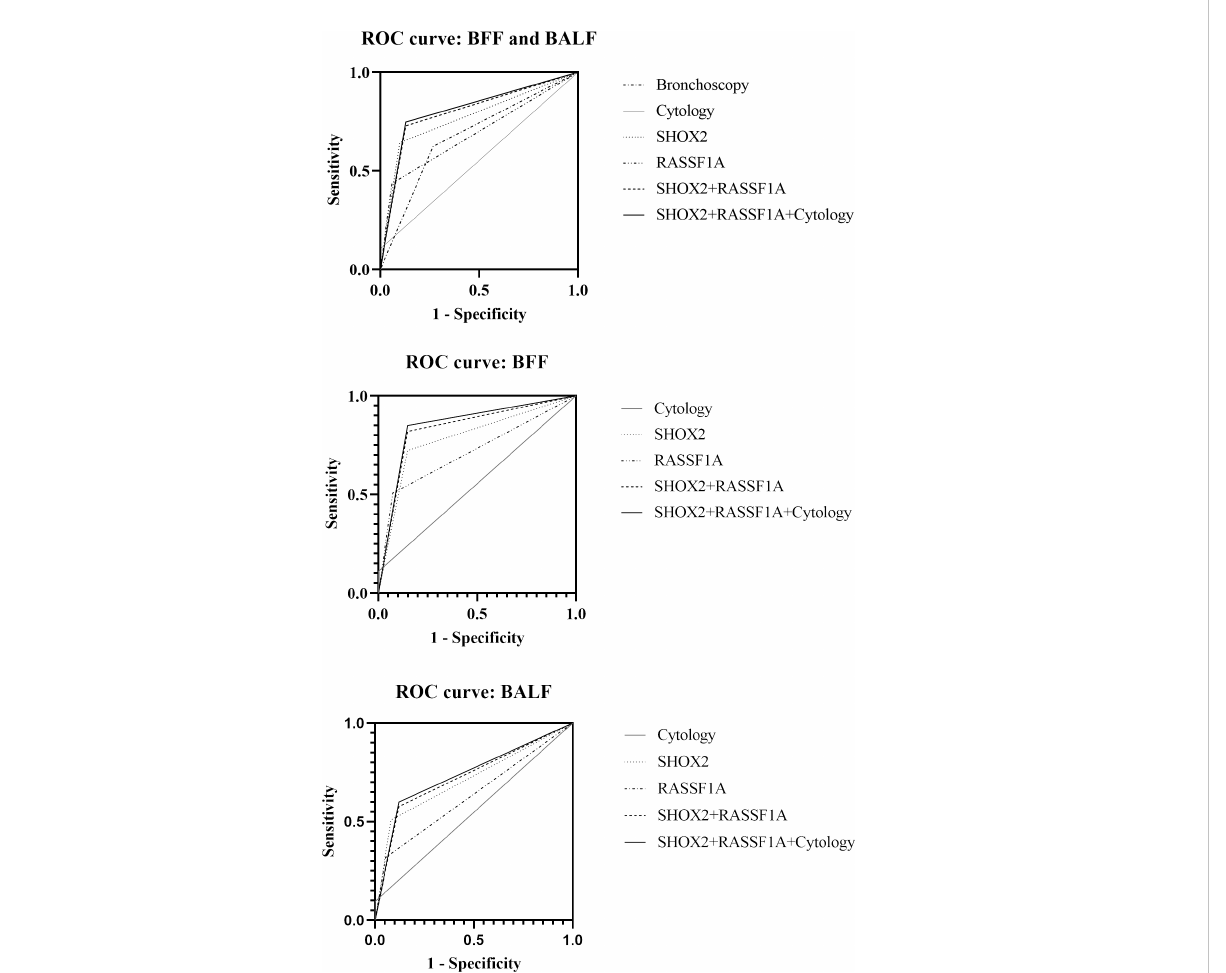
FIGURE 3 Receiver operating characteristic curve of bronchoscopy, cytology, and SHOX2 and RASSF1A methylation